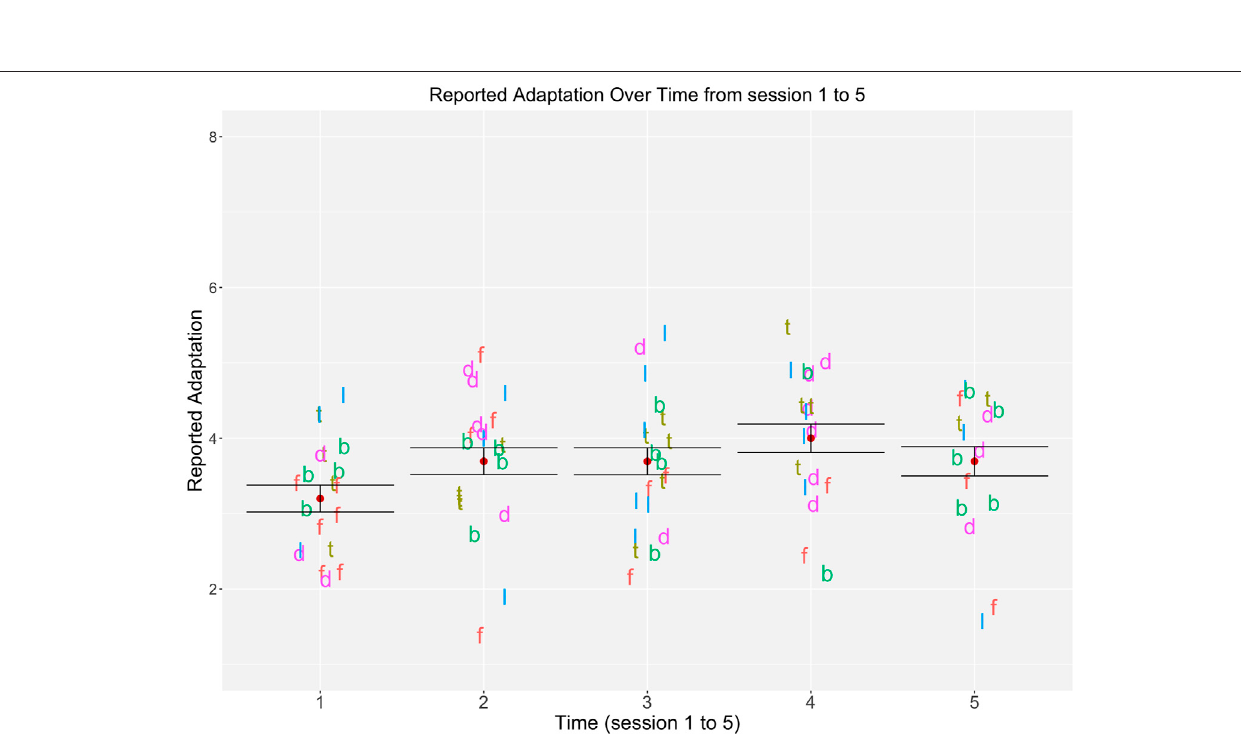
FIGURE 9 | Adaptation reported by participants for each session (1: not at all to 5: very much). Letters shows task names (f: fi shing, t: twenty questions, b: brainstorm, l: lifeboat, d: draw and guess). Dots represent mean and black bars show standard error of the mean.